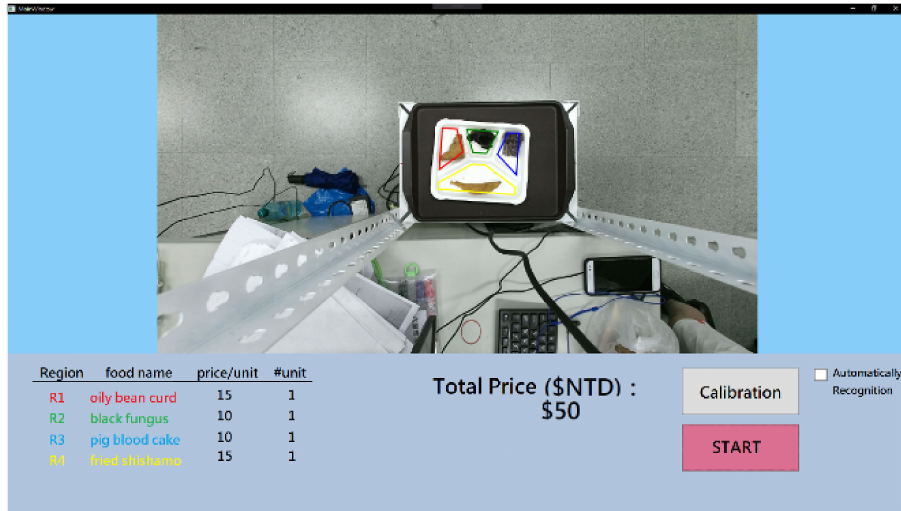
Figure 20. An example using the proposed visual checkout system to estimate food price.